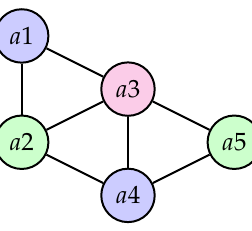
Figure 16. Conflict graph I cs .